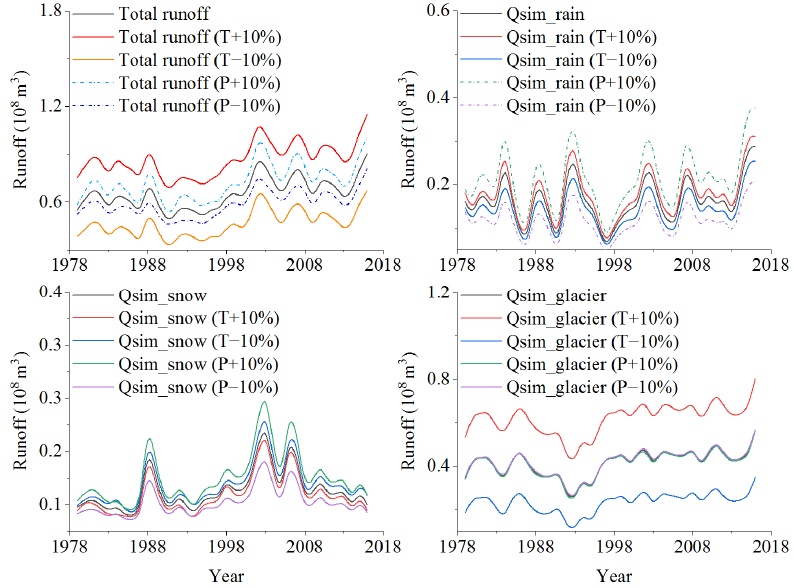
Figure 11. Sensitivity analysis for the total runoff, Qsim_rain, Qsim_glacier and Qsim_snow under the four climatic conditions.